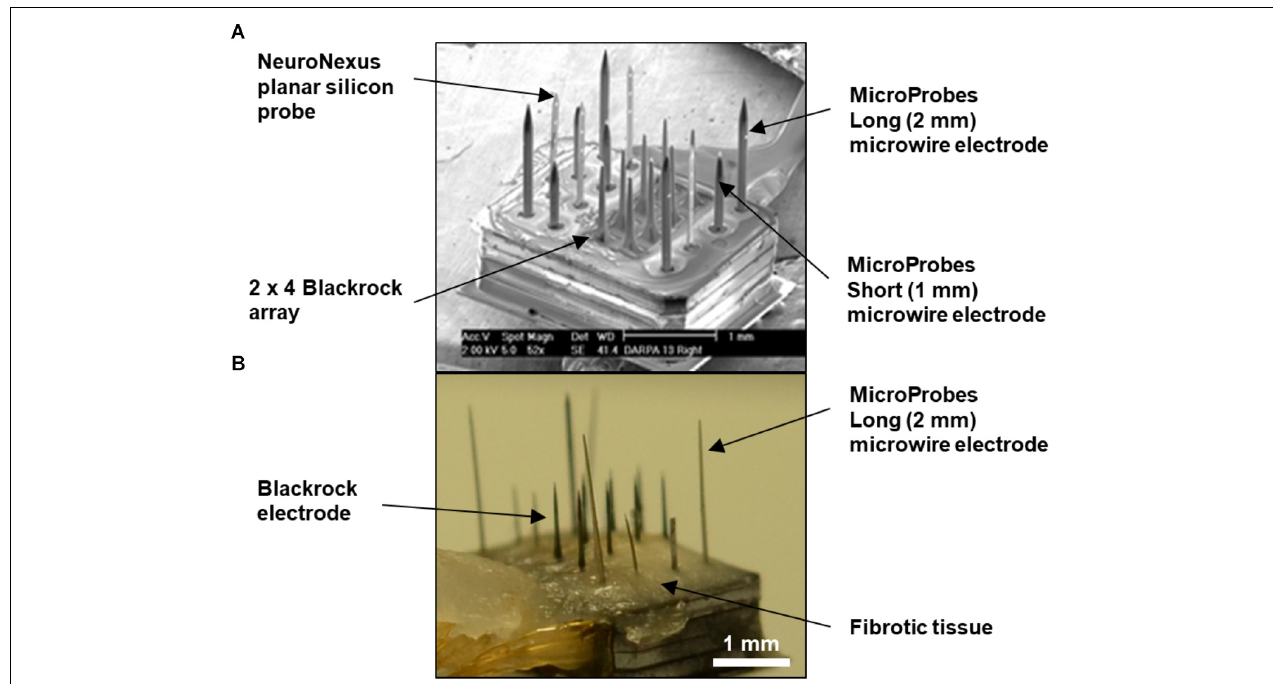
FIGURE 1 | (A) SEM of fully-assembled hybrid array before implantation showing four types of commercial microelectrodes assembled in a mixed fashion. The overall footprint of the array is approximately 1.7 mm × 2.2 mm. (B) Photograph of the explanted hybrid array from the animal used in this study. The base of the array was covered with fibrotic tissue, but the majority of the length of the electrodes appeared free of tissue. Also, the long microwire and NeuroNexus probes were tilted at an angle.